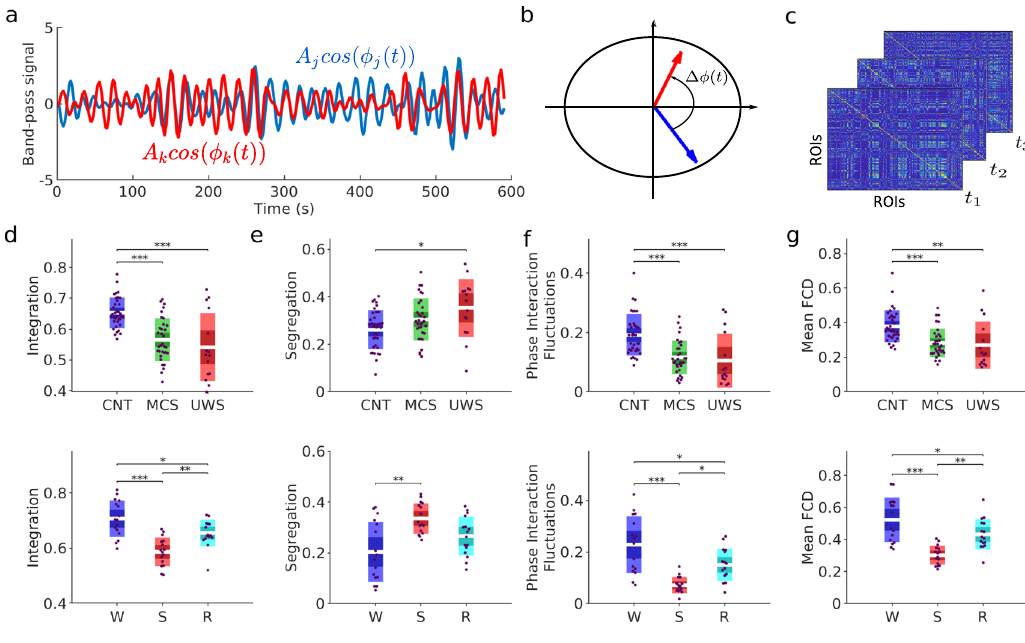
Fig. 1 Changes in global properties of phase dynamics induced by loss of consciousness. a BOLD band-pass signals (0.04 – 0.07 Hz) for two sample ROIs. The instantaneous phases, ϕ j (t) and ϕ k (t), of each signal were computed using the Hilbert transform. b At each time frame, the interaction between ROIs was given by the instantaneous phase difference, Δϕ jk (t) = ∣ ϕ j (t) − ϕ k (t) ∣ , which can be represented as vectors in the unit circle of the complex plane. c Phase- ð t ÞÞ , at time t . All global measures used afterwards were based on the interaction matrices P jk (t) were calculated as the cosine of the phase difference, cos ð Δ ϕ jk phase-interaction matrices. d – e The structure of phase interactions was described in terms of the integration and the segregation of the time-averaged phase interaction matrix (see “ Methods ” ). f We quanti fi ed the temporal fl uctuations of the mean phase synchrony (i.e., the average over ROIs of matrix P ( t )) through its temporal standard deviation. g To detect the existence of recurrent synchronization patterns, we computed the FCD comparing phase-interaction matrices at different times (see “ Methods ” ). Brie fl y, the FCD represents the (cosine) similarities between phase-interaction matrices at times t and t 0 for all possible pairs ( t , t 0). The panel shows the average similarity for each experimental condition. In panels ( d – g ), each dot represents a participant and the boxes represent the measure ’ s distribution. Boxplots represent the mean of the measures' values with a 95% con fi dence interval (dark) and 1 SD (light). Differences between groups were assessed using one-way ANOVA followed by FDR p -value correction. *: p <0.05; **: p <0.01; ***: p <0.001 (see Table 1 for details).